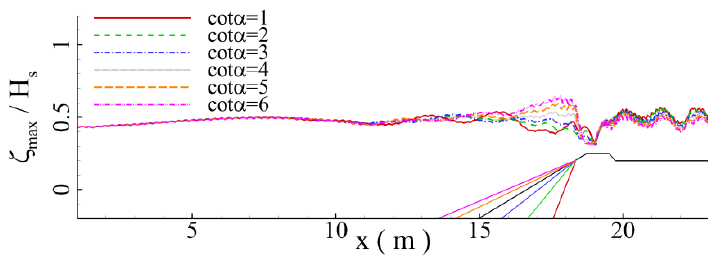
Figure 41. Space distributions of the maximum water surface elevation.